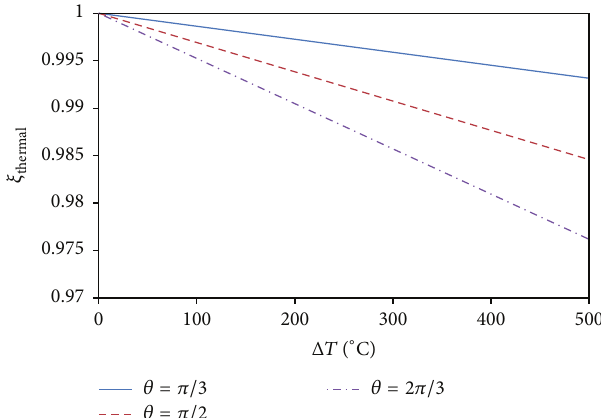
Figure 5: Vibration thermal ratio parameter of circular curved nanobeam with respect to temperature change (𝜇 = 1, 𝐾 𝑤 = = 10 −6 , 𝑅 = 10 nm ) 10 10 , 𝐾 𝑝